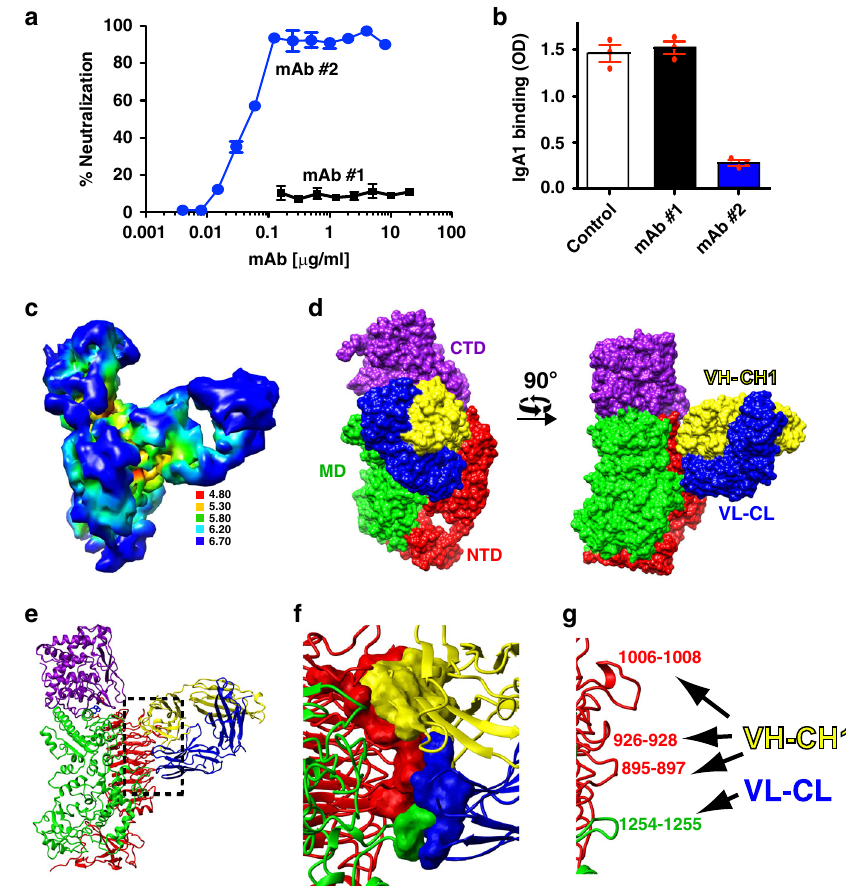
Fig. 4 Cryo-EM structure of an S. pneumoniae IgA1P/mAb complex. a ELISA-based neutralization assay comparing the blocking activity of two mAbs produced against IgA1P to cleave IgA1. The mAb #1 (black) previously developed does not neutralize IgA1P activity 21 and the currently characterized mAb #2 (blue) does neutralize IgA1P activity. IgA1P residues 154 – 1963 was incubated at 286 ng/ml (1.3 nM) with varying concentrations of the mAbs. For reference, 1 μ g/ml of each mAb is approximately 6.7 nM estimating the molecular weight as 150 kDa. Data are an average of n = 4 biological replicates with the standard error of the mean also shown. b S. pneumoniae IgA1P-E1605A binds to IgA1 (white), which is not blocked by mAb #1 (black) but is blocked by mAb #2 (blue). IgA1P-E1605A was plated at 1 μ g/ml and incubated with either buffer or 2 μ g/ml mAb. Data are an average of n = 3 biological replicates shown as a dot blot along with the standard error of the mean also shown. c 3D reconstruction of the S. pneumoniae IgA1P in complex with IgA1 colored according to local resolution estimates (units in Å). d Surface representation of the IgA1P/mAb complex (PDB ID: 7JGJ) with IgA1P shown in a similar orientation as Fig. 1 (left) and rotated 90° (right). The complex comprises IgA1P (colored as in Fig. 1) and both the mAb VL-CL (blue) and mAb VH- CH1 (yellow). e Ribbon structure of the IgA1P/mAb complex with the box highlighting the interaction regions. f Expansion of the interaction site with residues that form a contact surface within 3 Å shown. g Speci fi c interacting loops of IgA1P targeted by the mAb are shown. Source data for panels a and b are provided as a Source Data